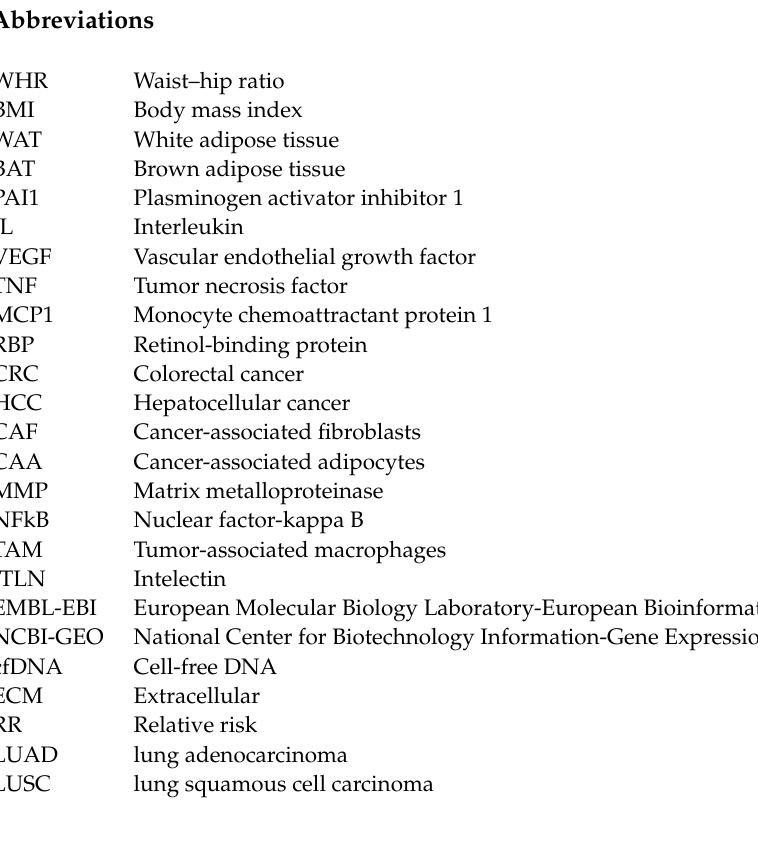
to normal lung tissue, Figure S2: K means clustered heatmaps and corresponding visualization, Figure S3: Regulation of lipolysis in adipocytes enriched in lung cancers compared to healthy lung tissue, Table S1: heterogeneity analysis of all datasets, Table S2: DEGs lung cancer vs. Normal lungs, Table S3: Kmean enriched clusters, Table S4: Enriched biological